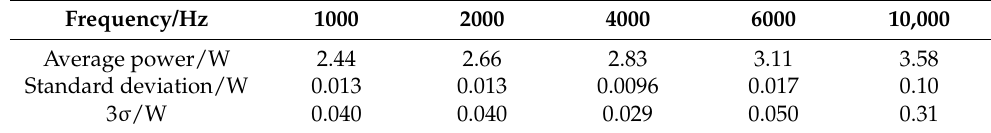
Table 4. Actual average power under different pulse frequencies (effective measurement time: 2.4 S).